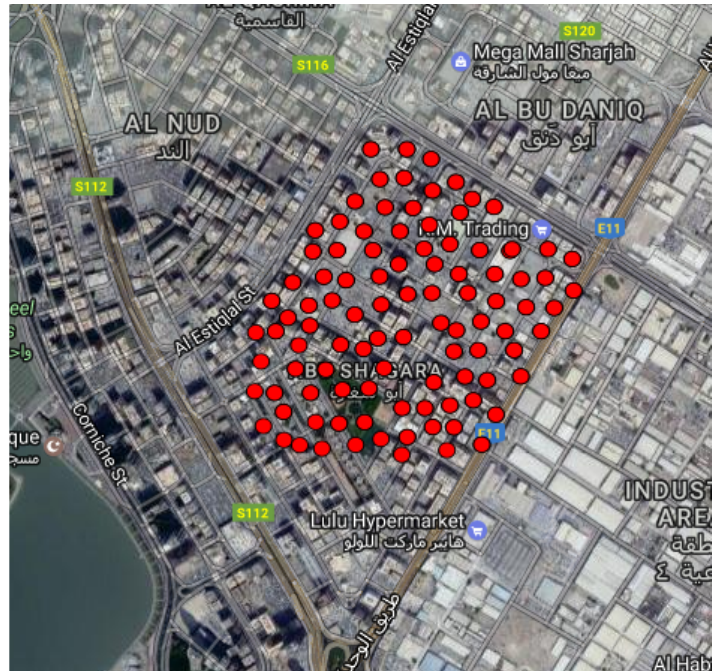
Figure 2. Sharjah city center, a typical scenario in which 100 sensors (red dots) are being placed at random location in a 200 by 200 m